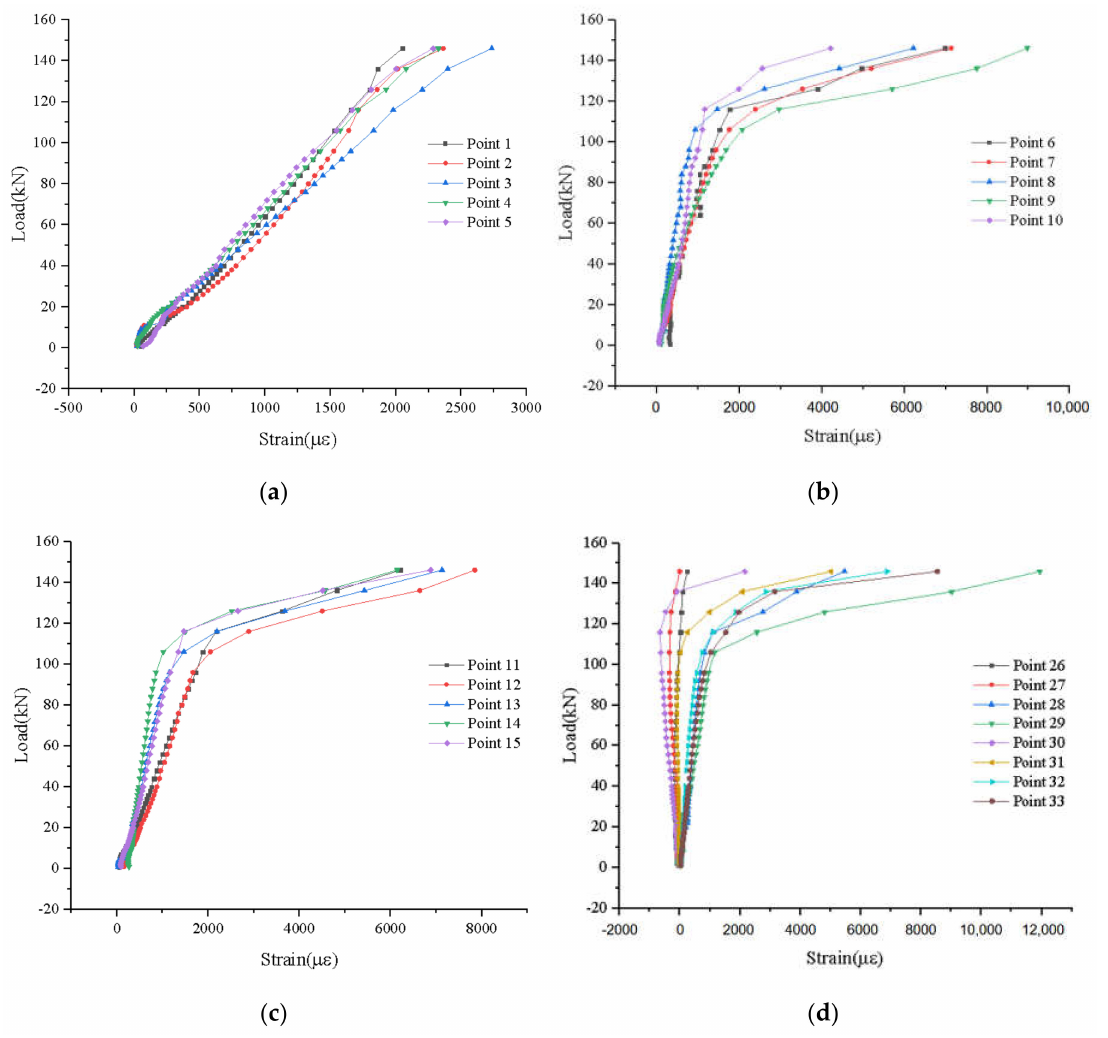
Figure 12. Load-strain curve of composite floor: ( a ) no. 1–5 strain gauge; ( b ) no. 6–10 strain gauge; ( c ) no. 11–15 strain gauge and ( d ) no. 26–33 strain